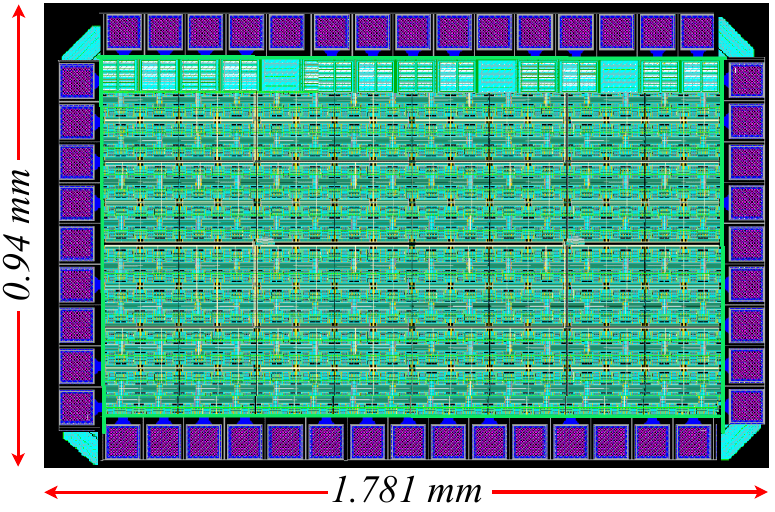
Figure 10. Layout of the proposed voting classifier, including the 3 centroid-based classifiers and the voting circuit.